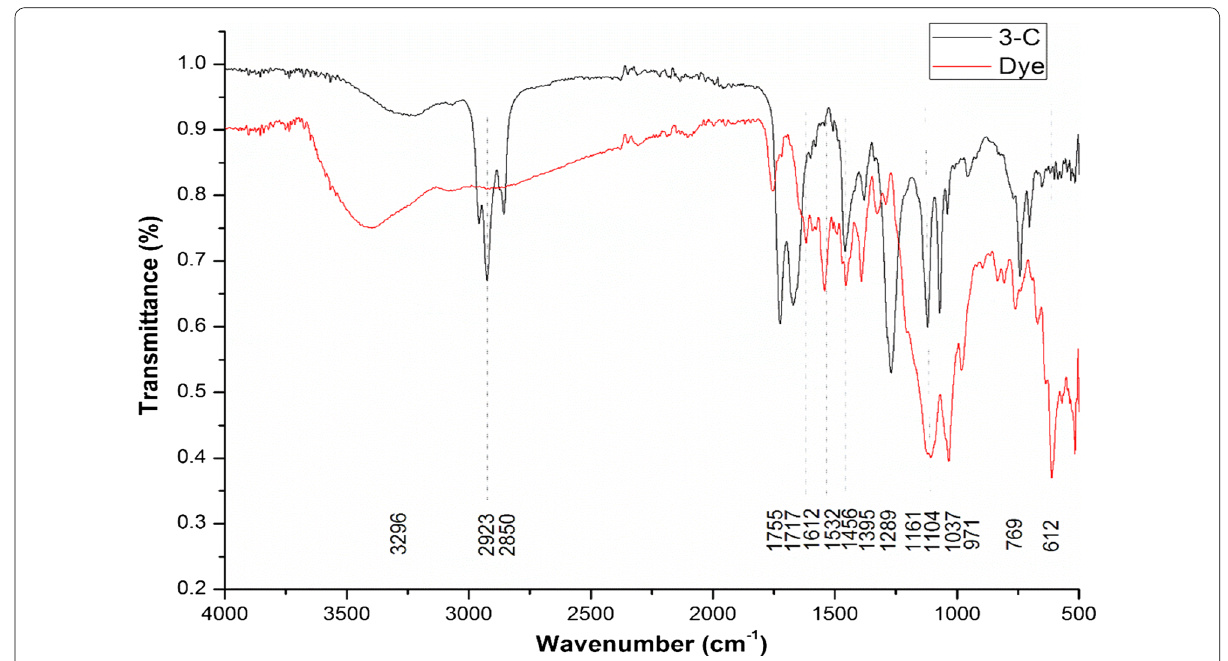
Fig. 5 FTIR spectrum of control dye (Synazol red 6HBN) and A. aquatilis 3c treated sample